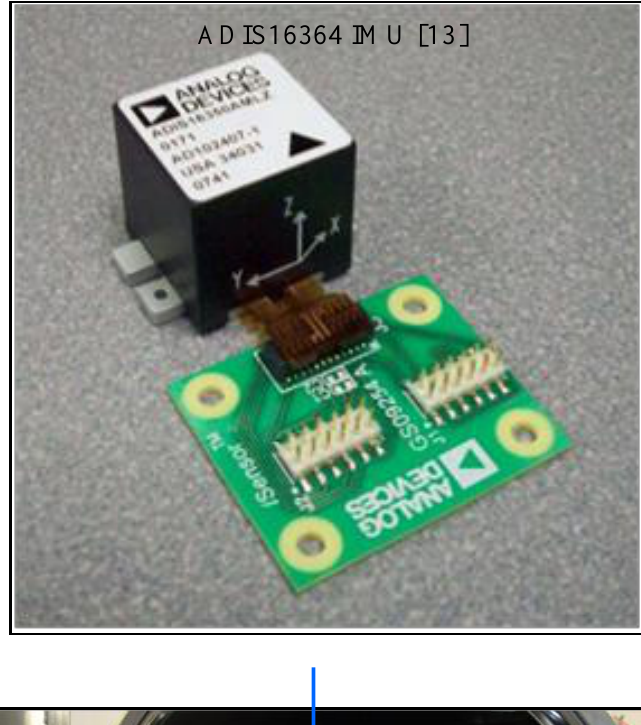
Figure 4. The thermal/vacuum chamber and the position of the IMU during